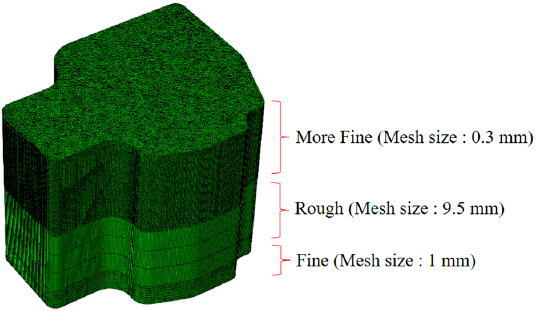
Figure 6. Mesh generation of initial specimen for extrusion process (blocker forming).